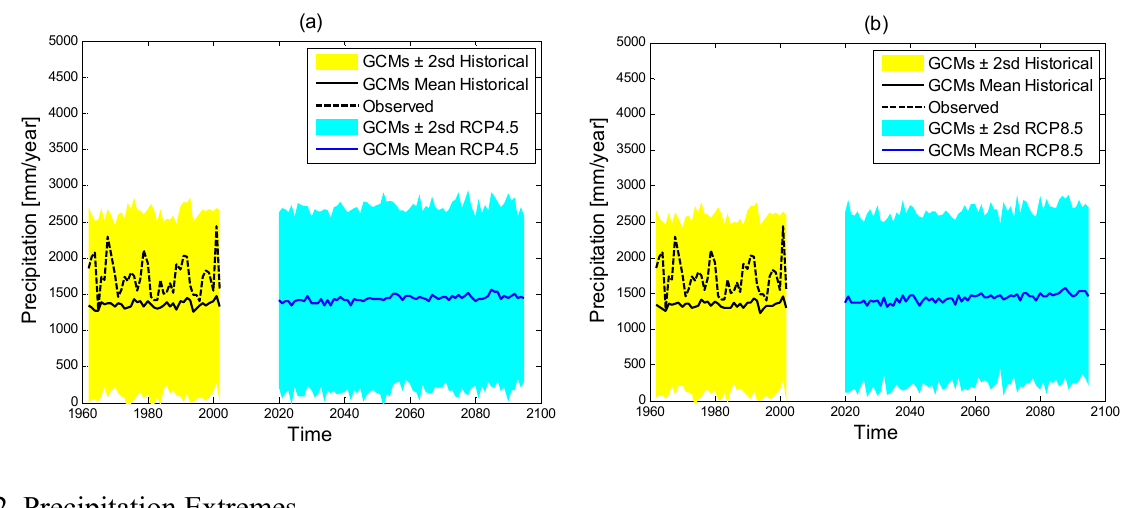
Figure 7. Annual variation of observed, and GCM output for ( a ) RCP4.5; ( b ) RCP8.5, GCM output bounds are based on twice the standard